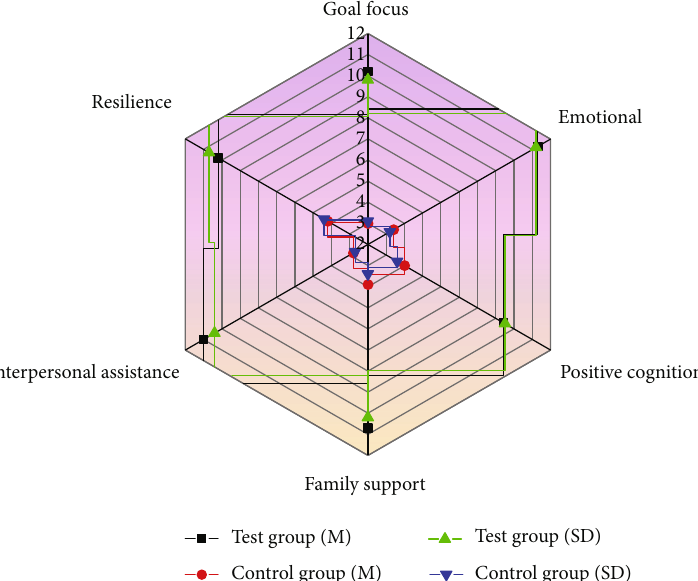
Figure 1: The di ff erence test of psychological resilience between the experimental group and the control group (pre-test).